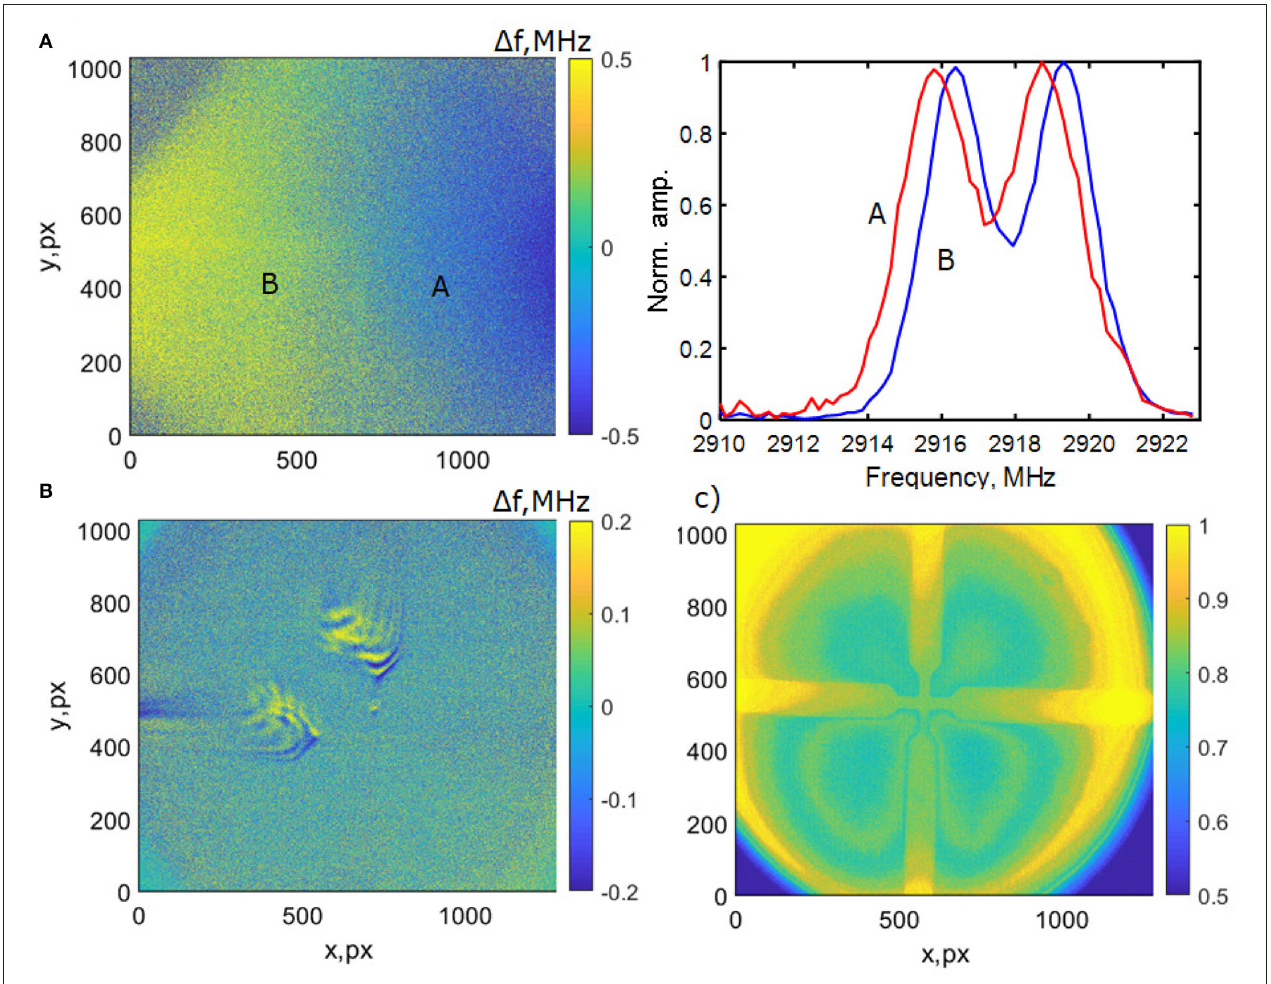
FIGURE 6 | Artifacts in fluorescence imaging experiments of a Ti/Au 50 nm cross on glass. In (A) the variation of microwave field is shown across an image with a field of view (FOV) of 1 mm (using a 10 objective). The result is a difference in brightness at a given MW frequency that can resemble a field shift, as can be seen in ∼ × the normalized ODMR plot averaging a 200 200 pixel region at different places (A,B) on the image. (B) The effect of vibrations (image wobble) on averaging of 100 × successive images taken at 1 ms intervals using a 100 objective with 100 µ m FOV. (C) Imaging at 7 Hz of vibrational modes of the diamond itself, which appear as × ≈ slight changes in brightness that can resemble magnetic field